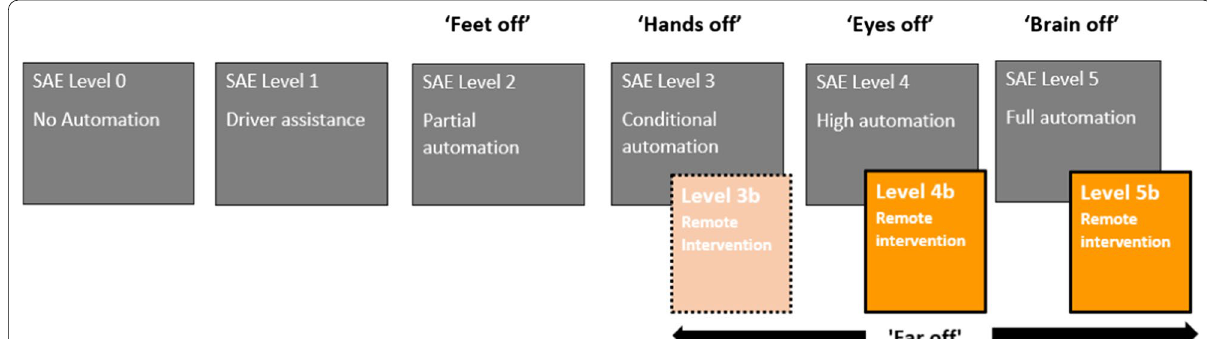
Fig. 5 Suggested revisions to the SAE (2016) taxonomy to allow for the potential handover to an RO by the addition of Levels 3b, 4b and 5b to the existing Levels 3, 4 and 5. The extra level proposed could be summarised as ’far off’, as the RO is intervening from a separate location (nb. ‘feet off, hands off, eyes off, brain off’ summary taken from Kemp 2018, p.